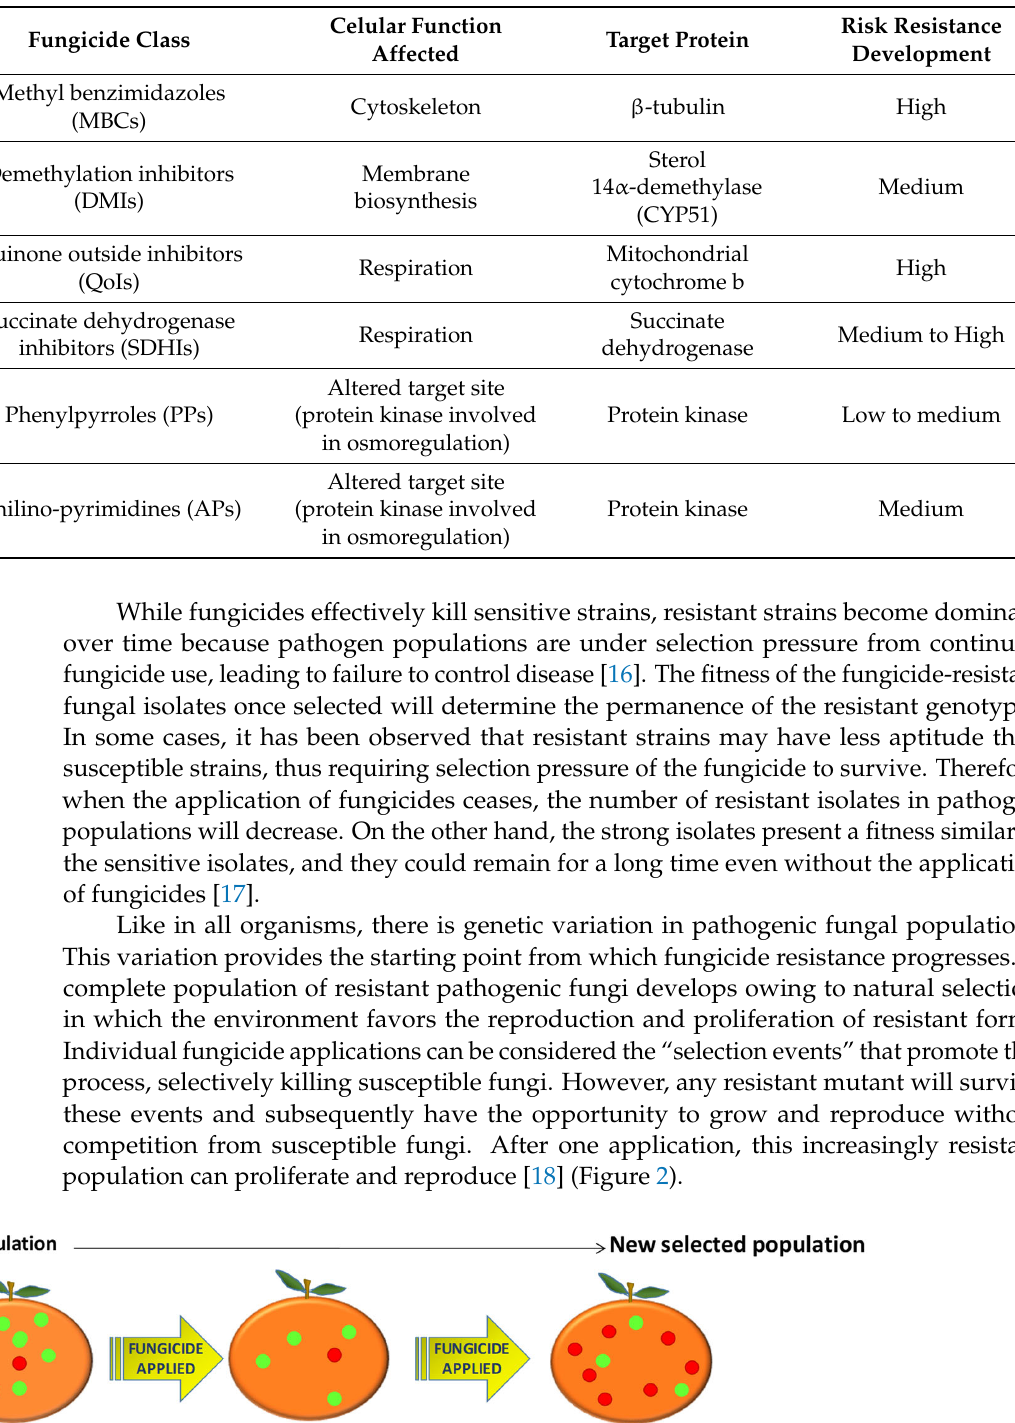
Table 1. Types of fungicides used in citrus control programs and their targets.